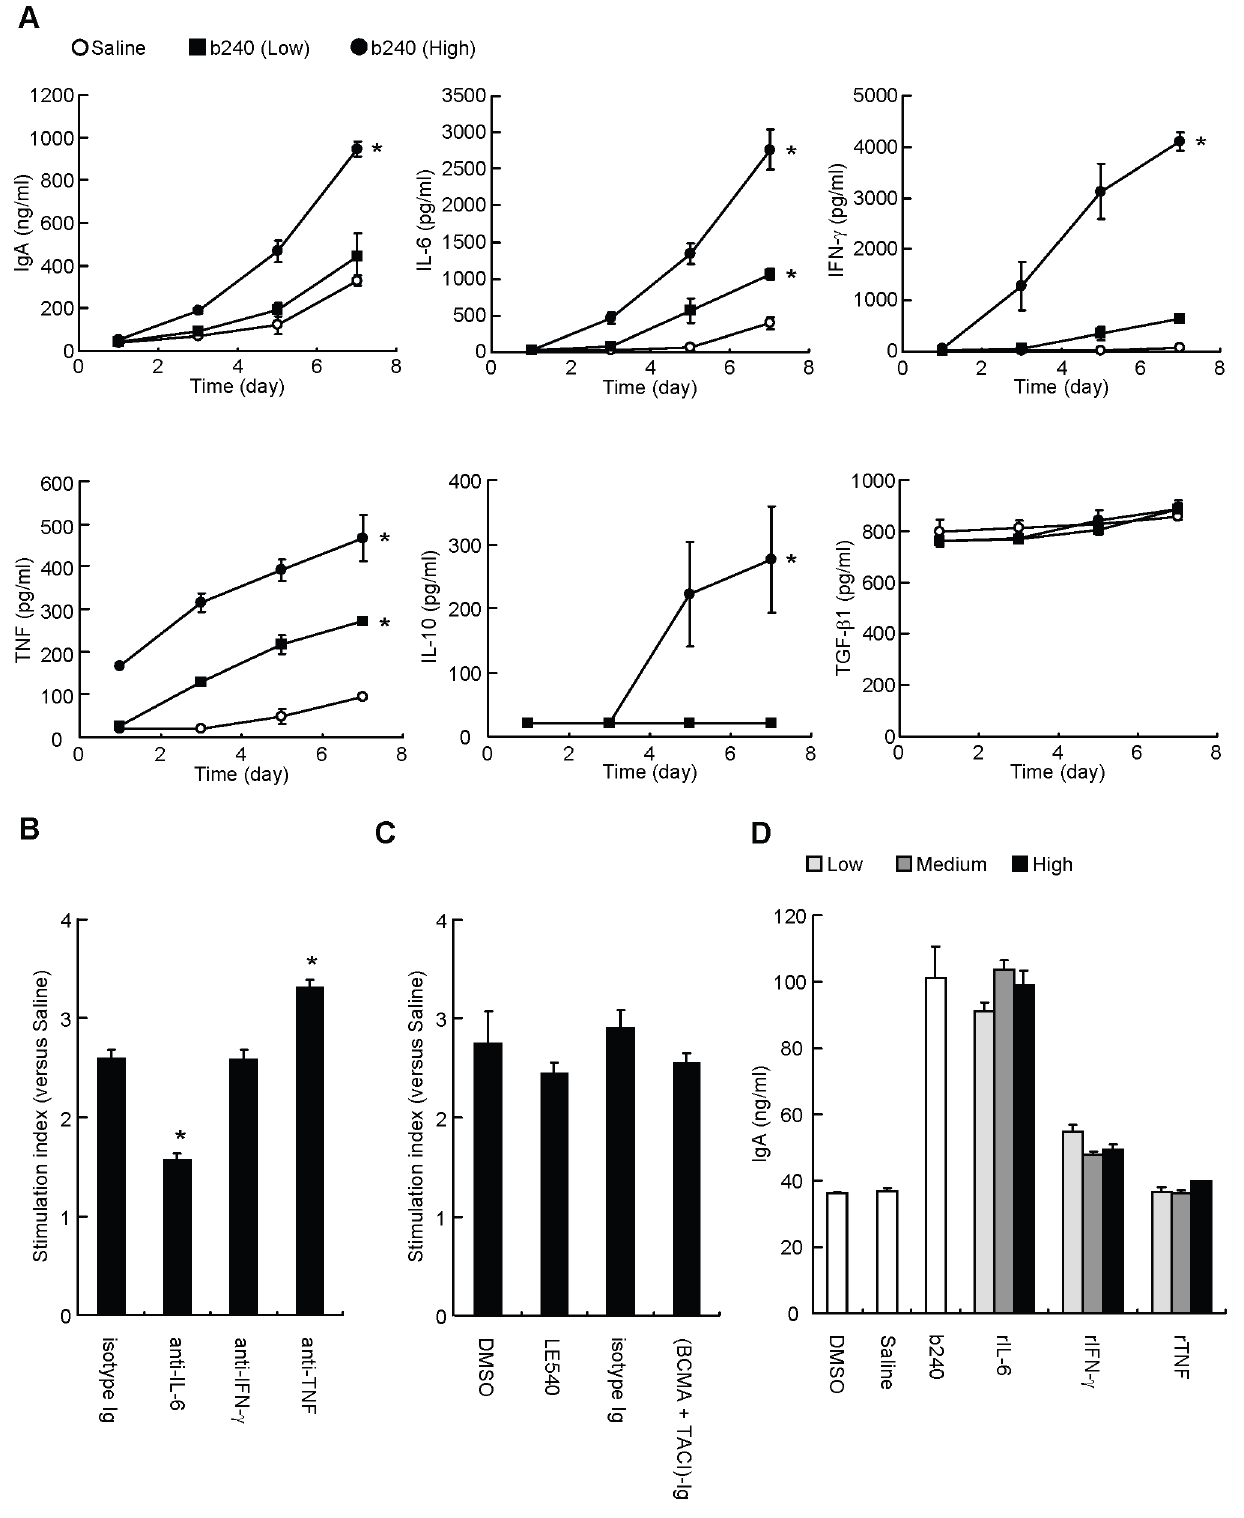
Figure 2. Important factor for the enhancement IgA production from PP cells by b240. (A) PP cells (1.5 6 10 6 cells) were cultured with saline (open circles), 1.2 6 10 6 counts of heat-killed b240 (closed squares), or 1.2 6 10 7 counts of heat-killed b240 (closed circles) for 1, 3, 5, and 7 days. (B, C) In the presence or absence of heat-killed b240 (4.7 6 10 6 counts), PP cells (5.8 6 10 5 cells) were cultured with (B) anti-IL-6 mAb (10 m g/ml), anti- IFN- c mAb (10 m g/ml), anti-TNF mAb (10 m g/ml), rat IgG1 k isotype control (10 m g/ml), (C) LE540 (1 m M), BCMA-Ig + TACI-Ig (5 m g/ml each), dimethyl sulfoxide, or human IgG1 Fc antibody (10 m g/ml) for 4 days. The stimulation index of each sample was calculated (for example, (b240-treatment and anti-IL-6 Ab treatment)/(saline-treatment and anti-IL-6 Ab treatment) is the stimulation index for anti-IL-6 Ab treatment). (D) PP cells (5.8 6 10 5 cells)